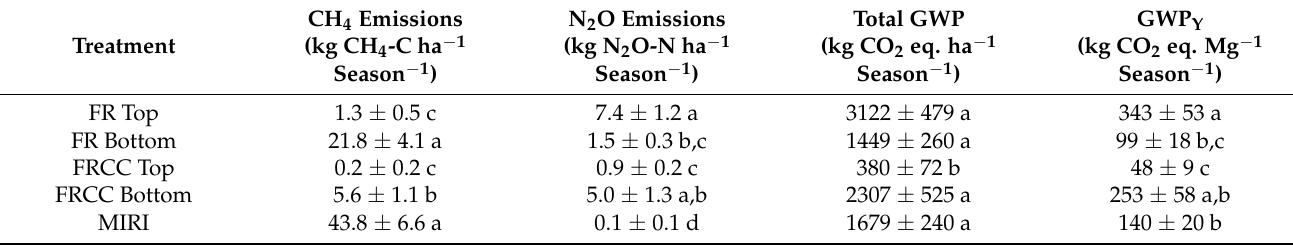
Table 4. Cumulative CH 4 and N 2 O emissions, total global warming potential (GWP) and yield scaled GWP (GWP Y ) of rice from top and bottom sections of furrow rice (FR), furrow rice with cover crops (FRCC) and multiple inlet rice irrigation (MIRI) system of rice cultivation during cropping season of 2019. Data shown are average ± standard error ( n = 5). Different letters denote statistical difference ( p < 0.05) among